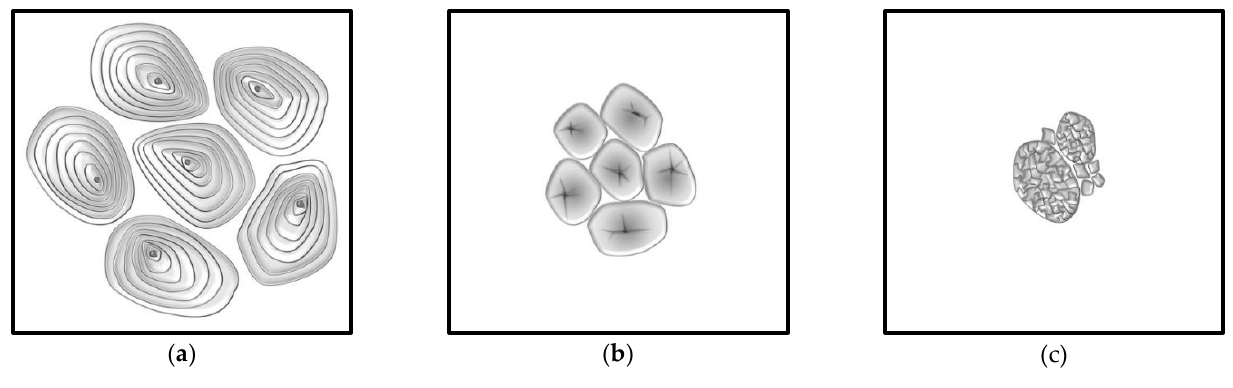
Figure 3. Native starch granule structure: ( a ) potato starch, ( b ) corn starch, and ( c ) rice starch. However, the native-Ps show the highest ε (cid:48) (31.48 at 500 Hz and 20.97 at 5 kHz) compared with the native-Rs (27.52 at 500 Hz and 19.37 at 5 kHz) and native-Cs (23.60 at 500 Hz and 16.88 at 5 kHz) at the frequency of 500 Hz and 5 kHz. Potato starch exhibited the highest average granule size (36 µ m in diameter), followed by corn starch (15 µ m in diameter). Meanwhile, rice starch shows the smallest average granule size (5 µ m in diameter) [8,25]. The results show that the larger granule size of the native potato starch significantly induces space charge accumulations at the grain boundary to create a potential barrier for interfacial polarization [3,21,24]. It is also clearly indicated that the modified starches exhibit a lower ε (cid:48) compared to the native starches. This might